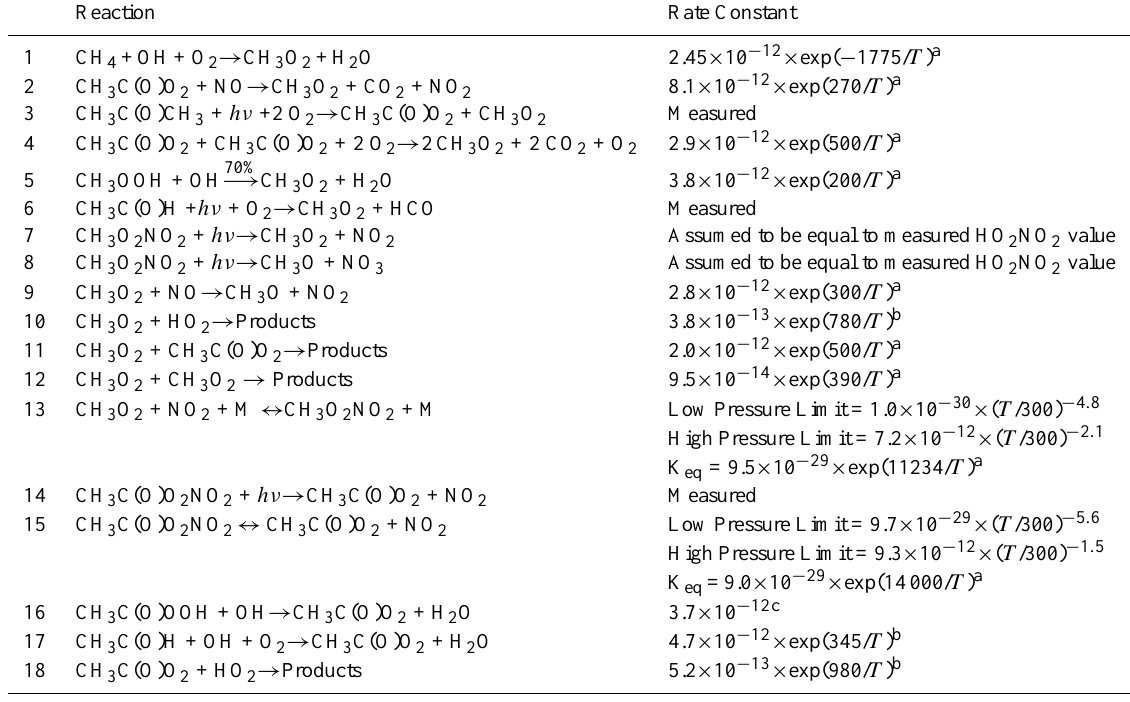
Table 2. Reactions and rates used in the photostationary state